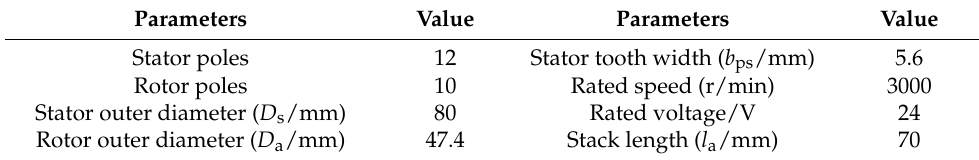
Figure 1. Magnetic poles and flux distribution in a six-phase SRM under winding connections with ( a ) NS alternative and ( b ) NNSS alternative. Table 1. Main parameters of six-phase SRM.